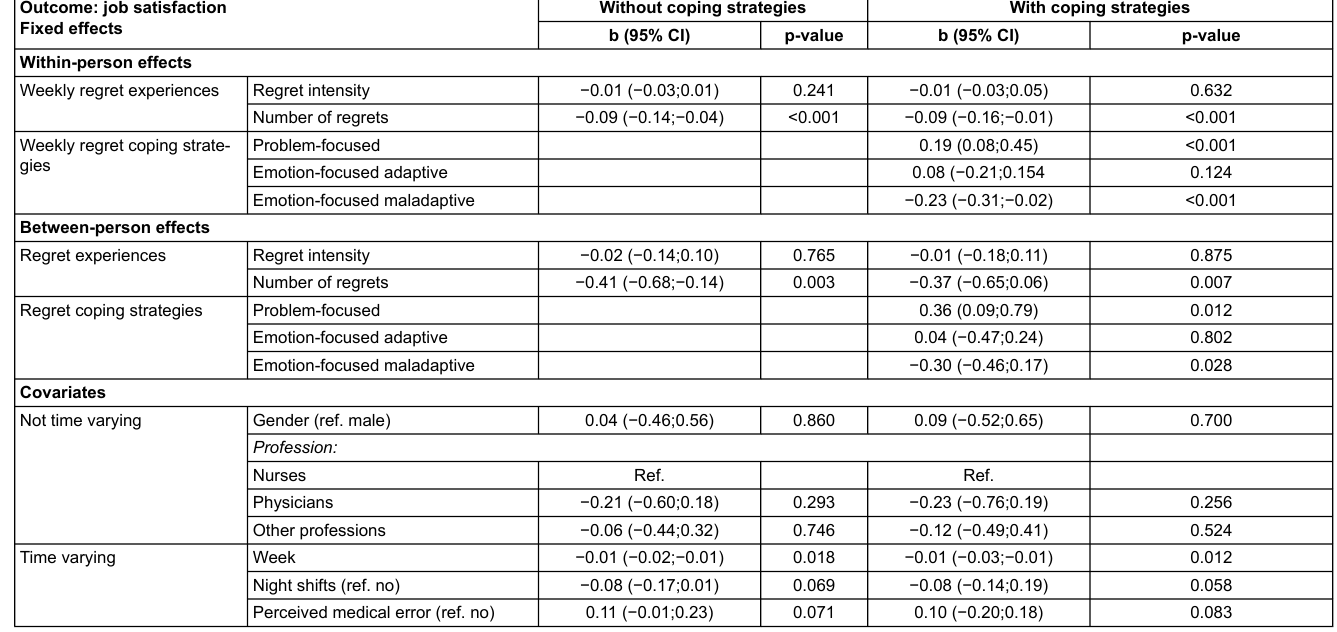
Table 2: Linear mixed models testing the association of within- and between-person variability in care-related regrets as predictors of job satisfaction and the mediation of cop- ing strategies. Outcome: job satisfaction Fixed